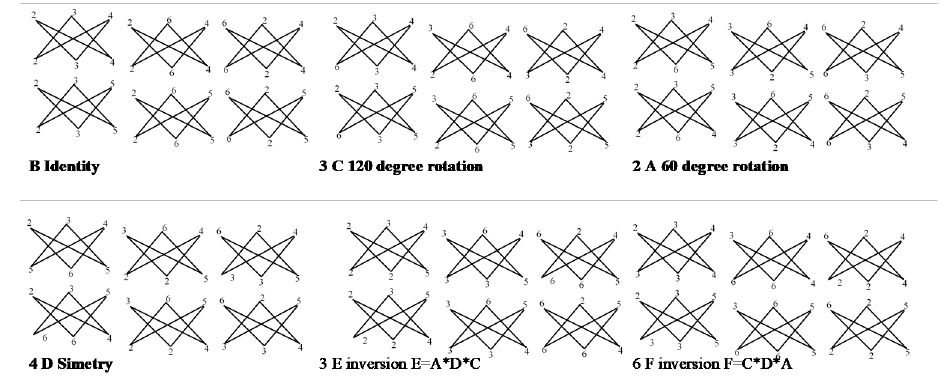
Figure 6. Feedback structures in the sustainable vector model. Reproduced with permission from Colceag F.